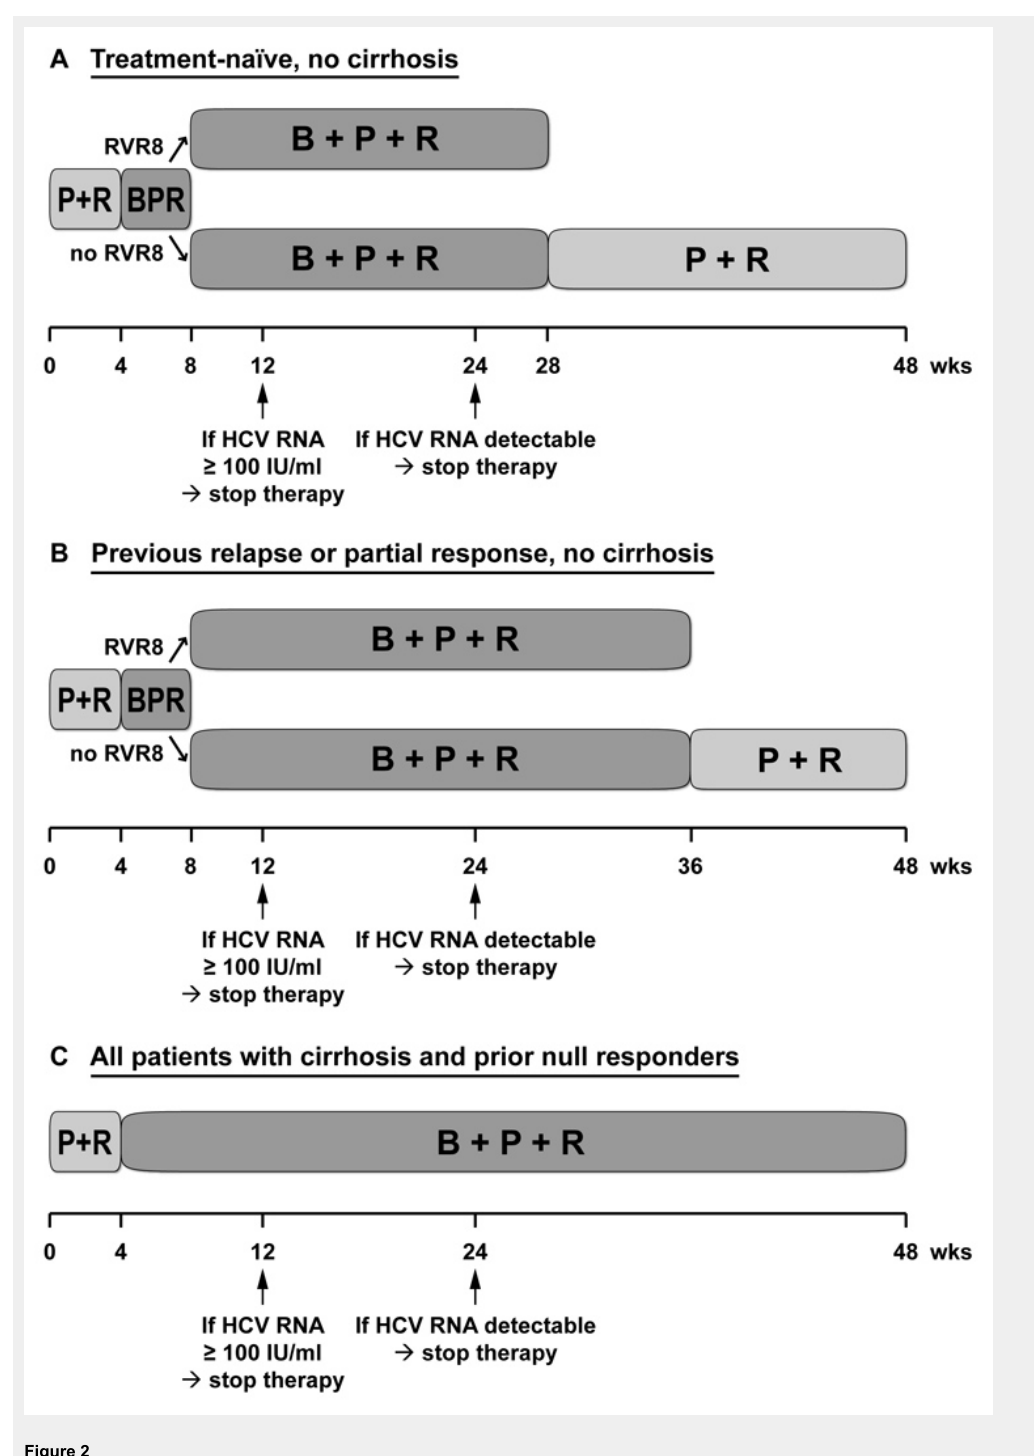
Figure 2 Boceprevir-based triple therapy. (A) Treatment-naïve patients with CHC of genotype 1 without cirrhosis. (B) Treatment-experienced patients with CHC genotype 1 and previous relapse or partial response without cirrhosis. (C) All cirrhotic patients and prior null responders. B, boceprevir; BPR = B + P + R; P, pegylated interferon-α; R, ribavirin; RVR8, rapid virological response at week 8 (see table 1 for definitions of virological response patterns); wks,